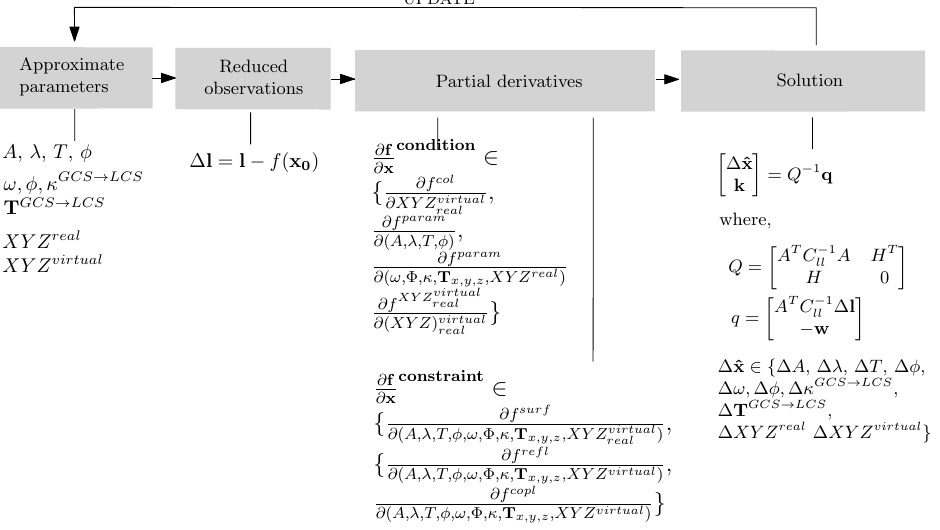
Figure 7. The least squares adjustment workflow of Method 2. The cycle repeats until the stop criterion is reached. ∂ x denotes the entire vector of parameters; A is the Jacobian in observations equations; H is the Jacobian in constraint equations; k is the Lagrange multiplier; and C ll is the covariance matrix. See f param , f surf , f refl , f copl in Equations (6)–(9),